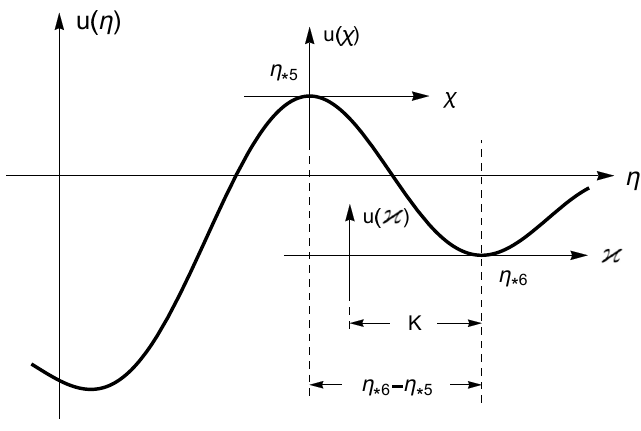
Figure 2 . The { -coordinate replaces the (cid:31) 0